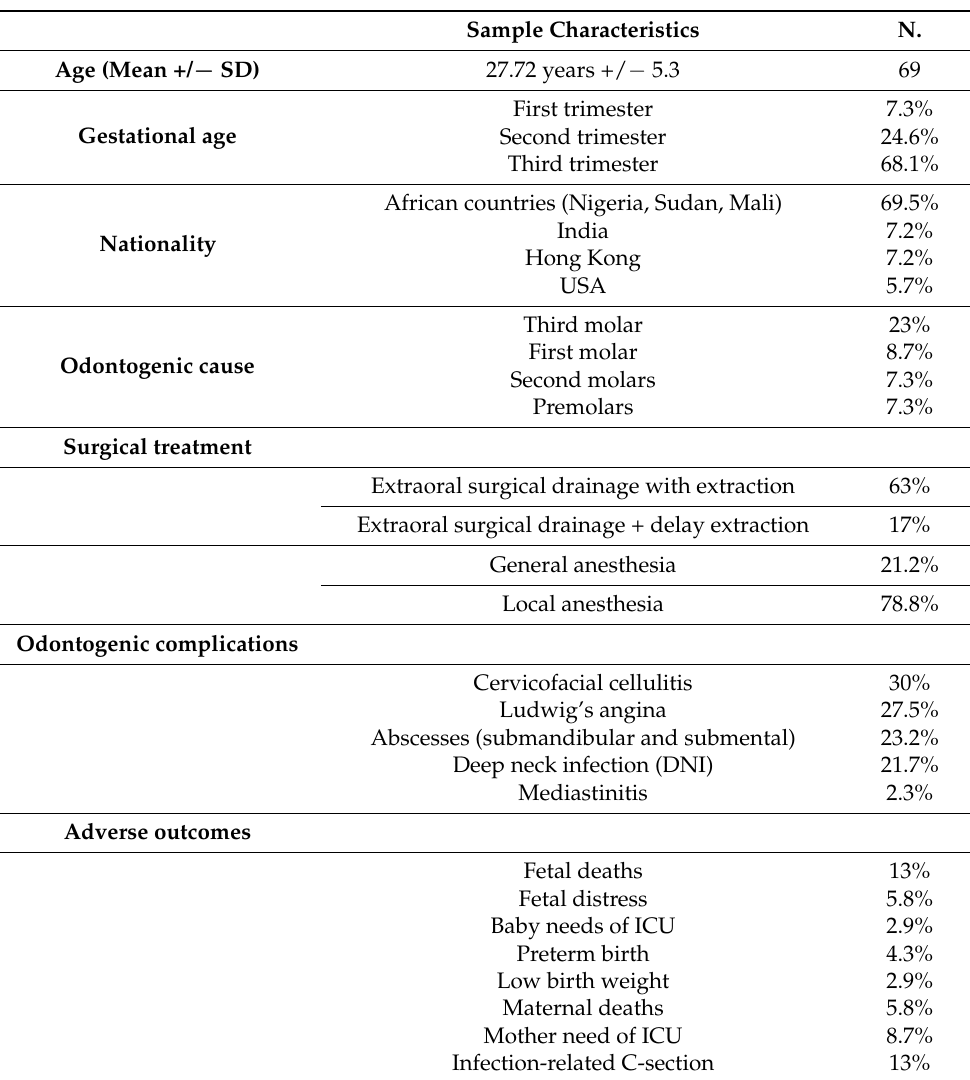
Table 5. Sample characteristics. Summary of the